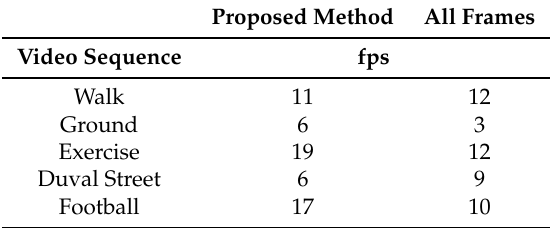
Table 2. Comparison of fps for the proposed method and the All Frames method.